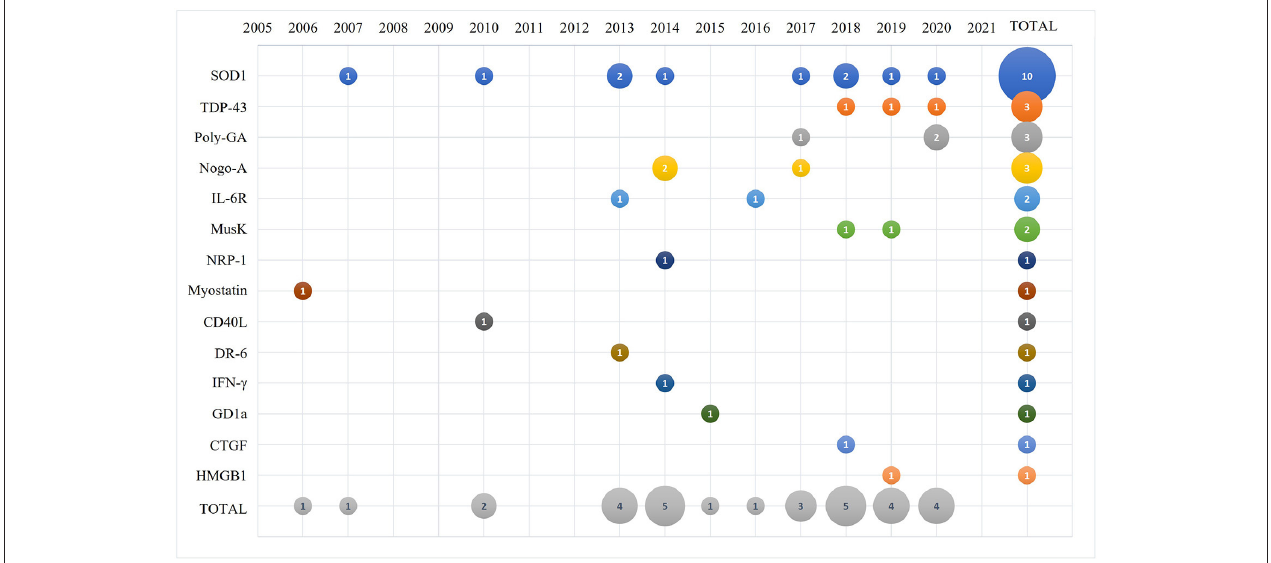
FIGURE 2 | Bubble plot of the 31 selected and analyzed papers describing the number of manuscripts published (number in the bubble) per selected target (y-axis) and time